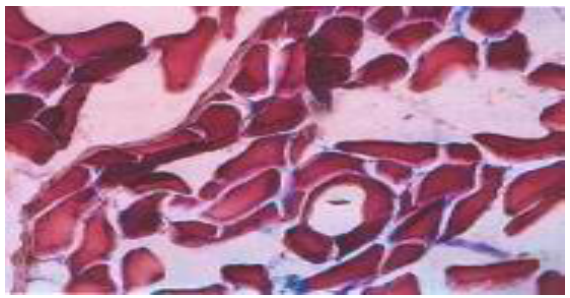
Fig. 1. Spectrum of the sample of the source meat raw materials.